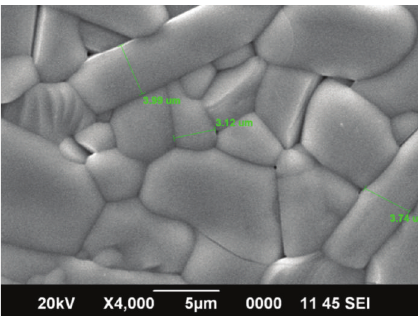
Figure 8: SEM micrograph of CaNb 2 O 6 .